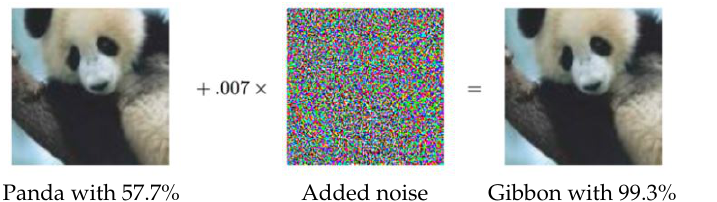
Figure 13. An adversarial example taken from [61]. Even though the given image and the image after adversarial noise added look exactly the same to the human eye, the noise fools the model successfully, i.e., the model labels the two images as different